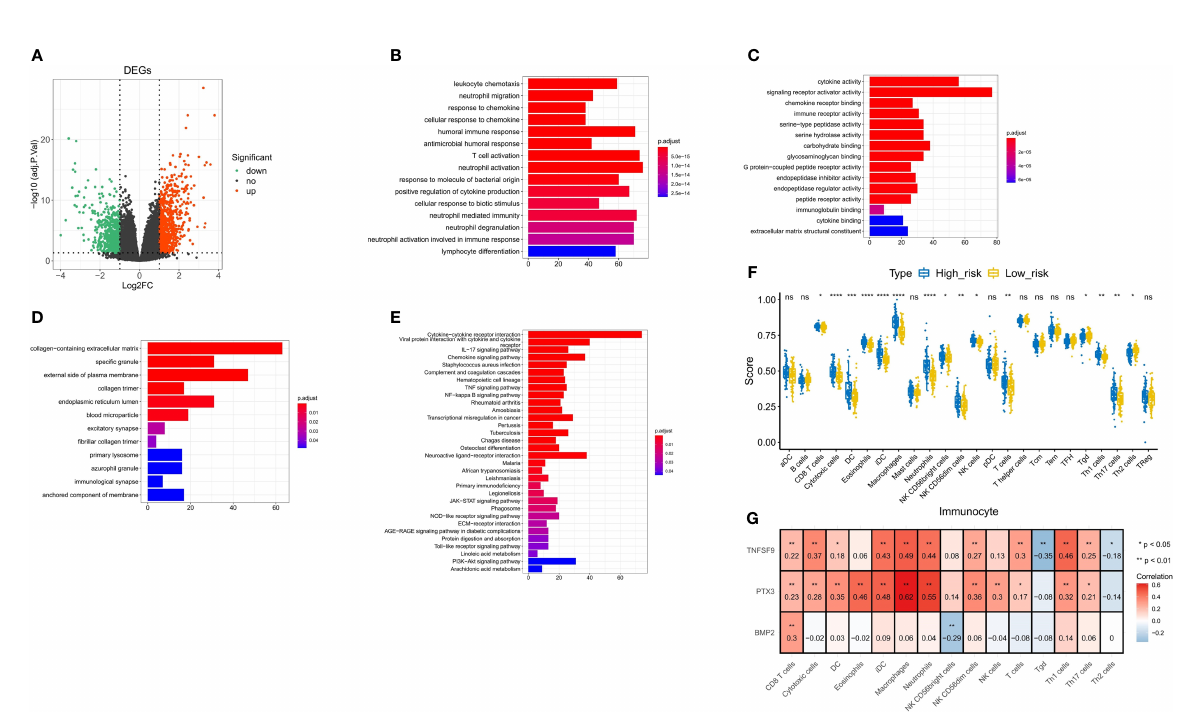
FIGURE 10 Correlation analysis of immunity and in fl ammation in the high- and low-risk groups. (A) Volcano plot for DEGs between the high- and low-risk groups. (B – D) The top 15 terms enriched by GO-BP/MF/CC functional enrichment analyses. (E) Thirty-two pathways enriched by KEGG functional enrichment analysis. (F) Difference of 15 immune cell in fi ltrations between the high- and low-risk groups. (G) Spearman correlation between three model genes and 15 differential immune cells. * p<0.05 vs. control; ** p<0.01 vs. control; *** p<0.001 vs. control; **** p<0.0001 vs. control; ns, not statistically signi fi cant.